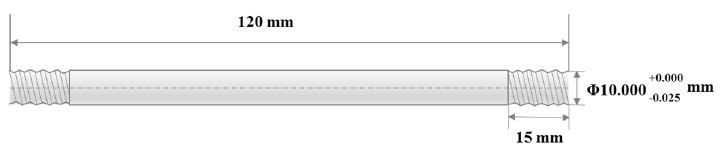
Figure 4. Specimen for hot ductility testing.